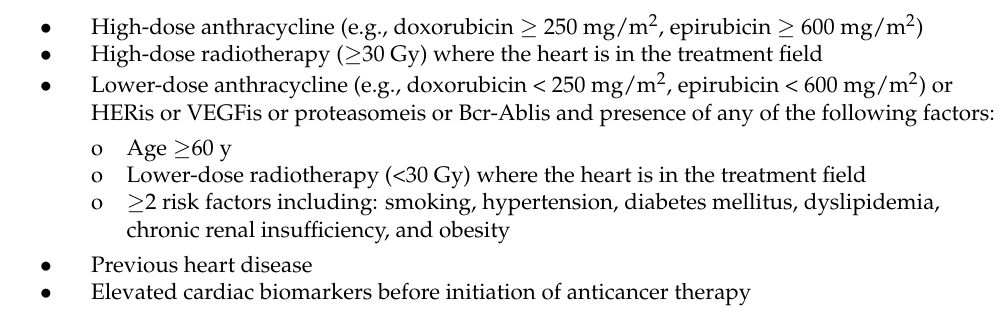
Table 1. Patients with higher risk for cardiotoxicity.